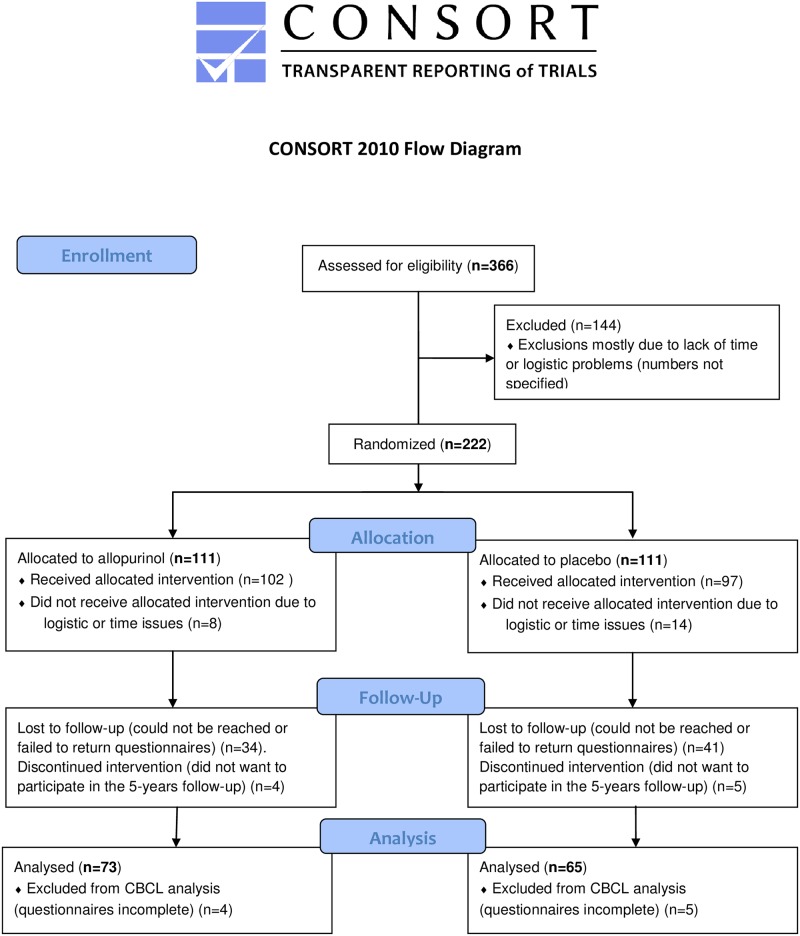
CONSORT flow diagram of the ALLO-trial and its follow-up.ALLO-trial: Antenatal allopurinol trial for reduction of birth asphyxia induced brain damage. ASQ: Ages and Stages Questionnaire, CBCL: Child Behavior Checklist.